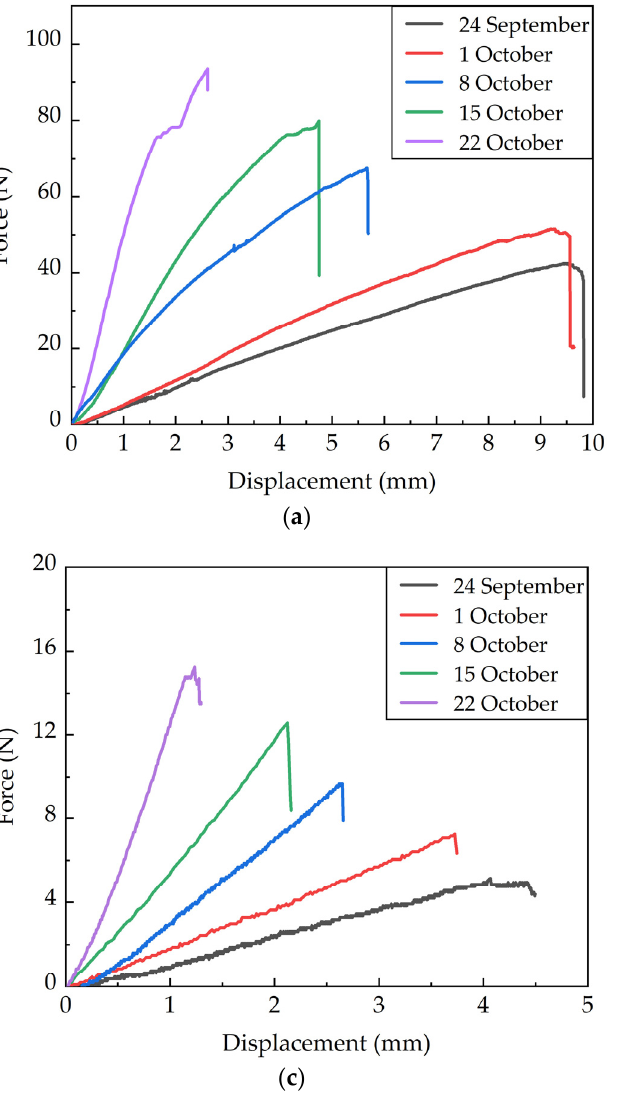
Figure 4. Force-displacement curves of the tensile test of the third leaf blade from five harvest days during the 2020 harvest season: ( a ) longitudinal tensile curves of Feitian 358; ( b ) longitudinal tensile curves of Jidan 558; ( c ) transverse tensile curves of Feitian 358; ( d ) transverse tensile curves of Jidan 558.